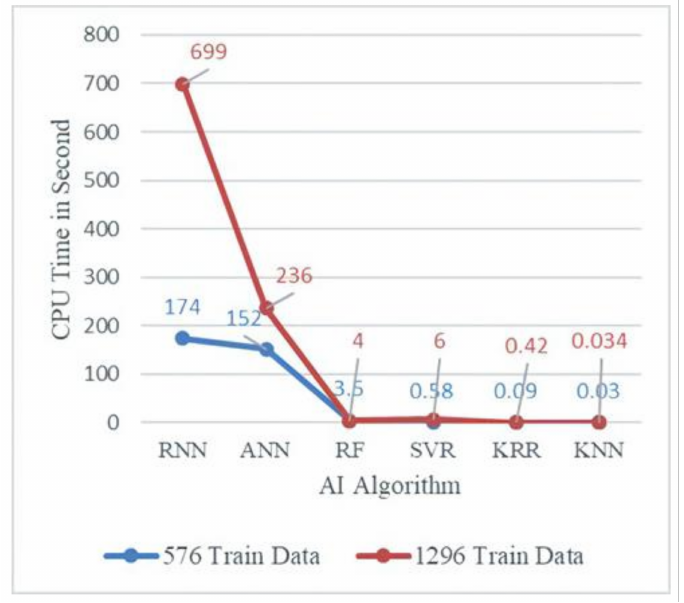
Figure 17. CPU time vs. AI algorithms for 576 and 1296 training datasets.